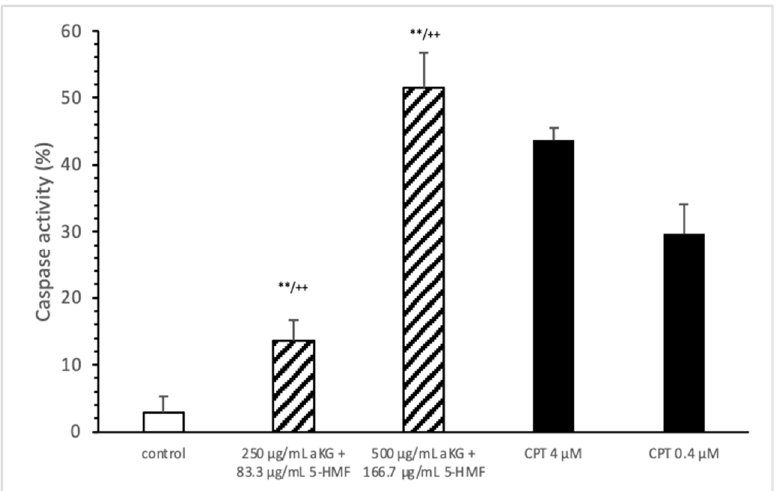
significance (63.2 ± 5.6%; n = 3; p < 0.001) compared to the control and to 4 µ M CPT ( n = 3; p < 0.05).